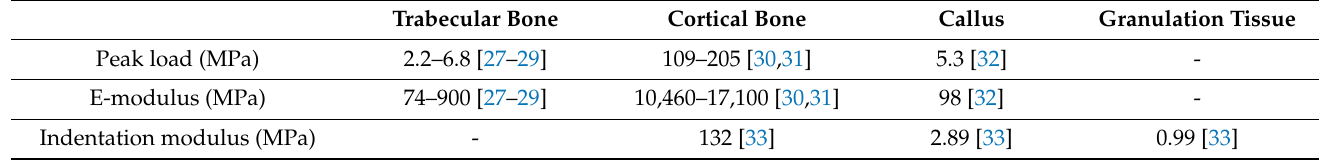
Table 1. Mechanical properties of different types of bone tissue determiend in biomechanical studies. Trabecular Bone Cortical Bone Callus Granulation